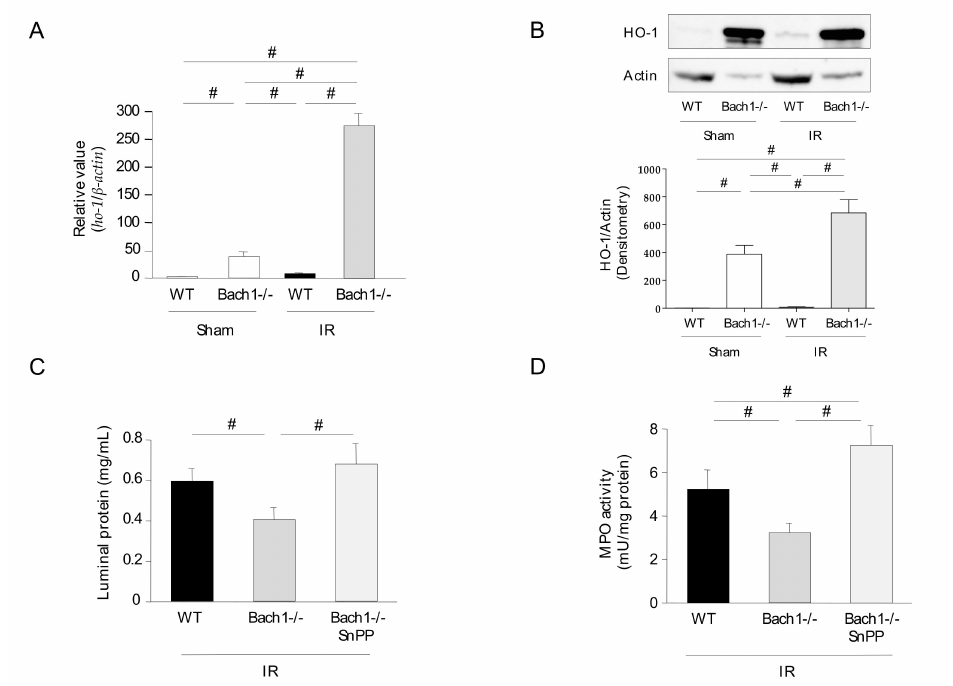
Figure 2. Effect of Bach1 deficiency on heme oxygenase (HO)-1 expression in intestinal IR injury. ( A ) ho-1 mRNA expression levels (real-time PCR) ( n = 7), ( B ) HO-1 protein expression levels (western blotting) ( n = 4), ( C ) Luminal protein expression levels (a Bio-Rad Protein Assay kit) ( n = 5), and ( D ) MPO activity ( n = 5). Sham operation or intestinal IR injury was induced in the wild-type and Bach1-deficient mice. Tin protoporphyrin IX (SnPP), an HO-1 inhibitor, was administered to IR-induced Bach1-deficient mice. Each value represents the mean ± SEM. # p < 0.05 compared between the selected